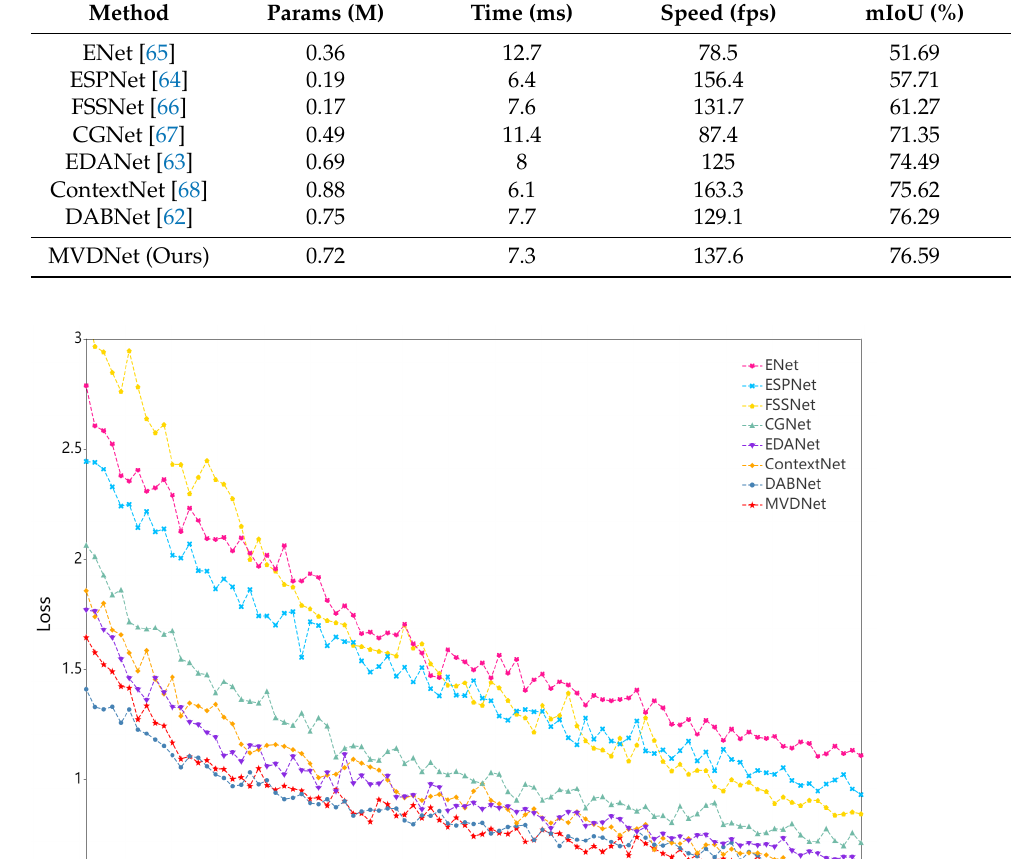
Table 8. Speed and accuracy comparison of MVDNet on the MVD test set.